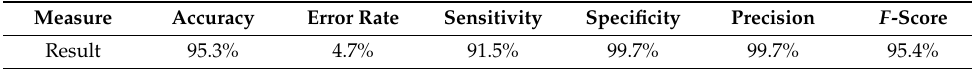
Table 12. Evaluation measures for the ORB algorithm over the 1500 patches.